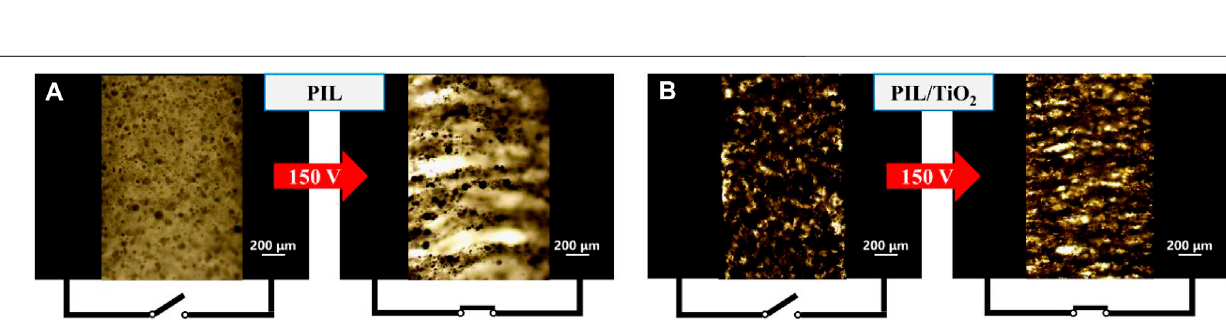
Frontiers in Materials |